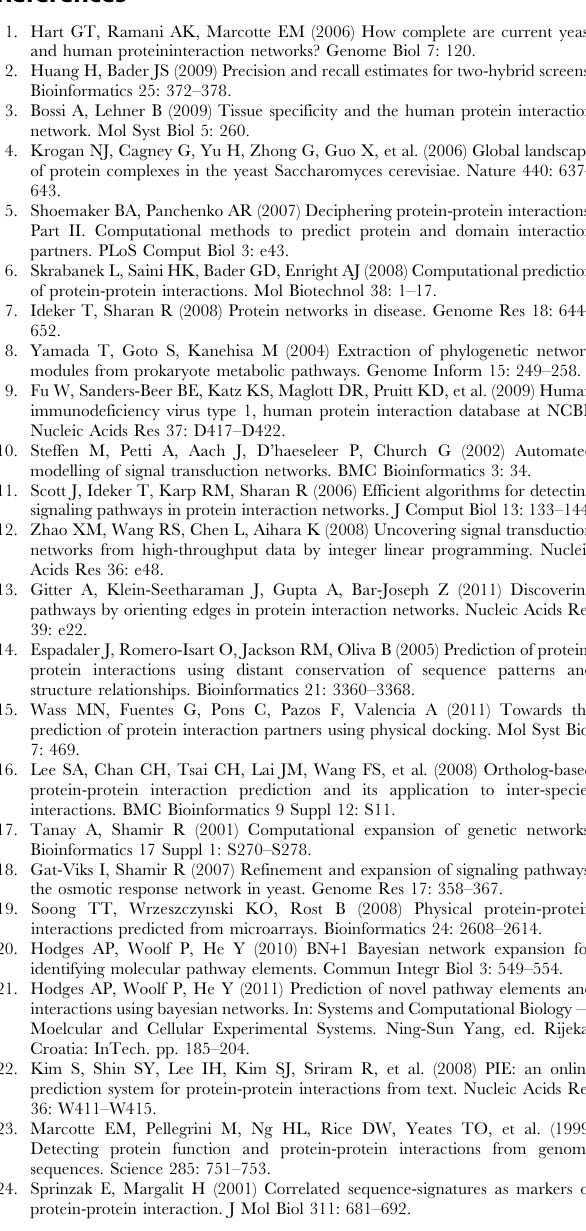
Figure S1 The instances of (A) Shortcuts and (B) Shortcuts-X used in the reduction from X3C. Figure S2 The prediction accuracy of each method using the unoriented STRING PPI network. (A) Accuracy in identifying STRING potential edges. (B) Accuracy in identifying STRING potential edges that are also HOG-relevant. Figure S3 The prediction accuracy of each method using a hop-restriction length of 4. (A) Accuracy in identifying STRING potential edges. (B) Accuracy in identifying STRING potential edges that are also HOG-relevant.